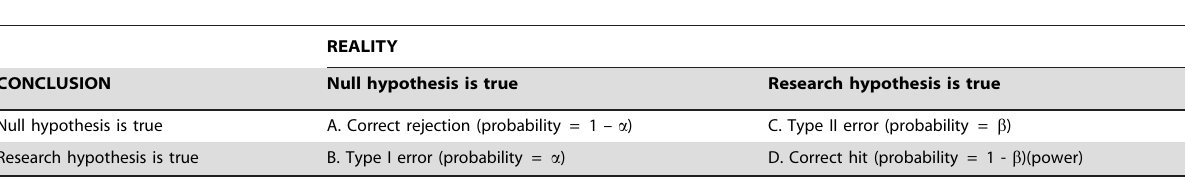
Table 1. Correct and Incorrect Conclusions in